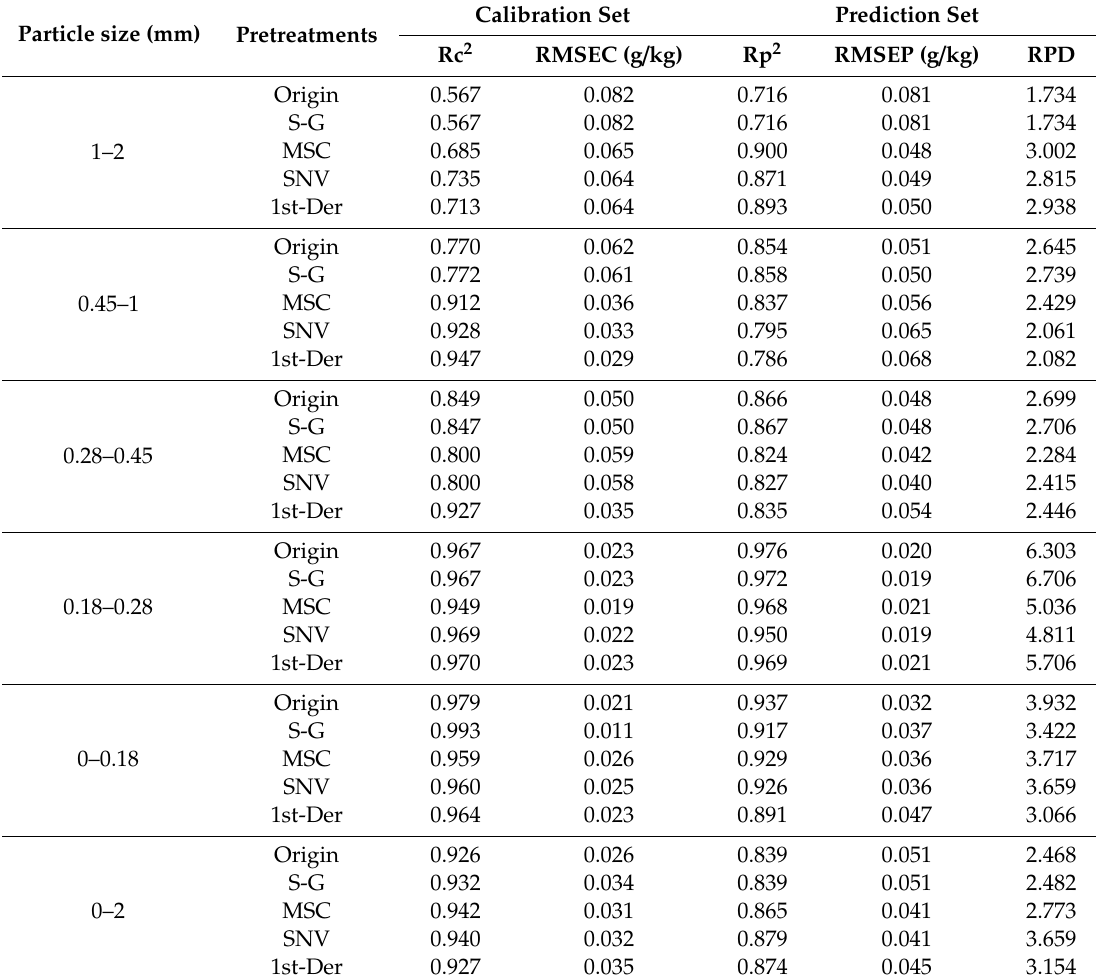
Table 1. The PLS model prediction of di ff erent soil particle